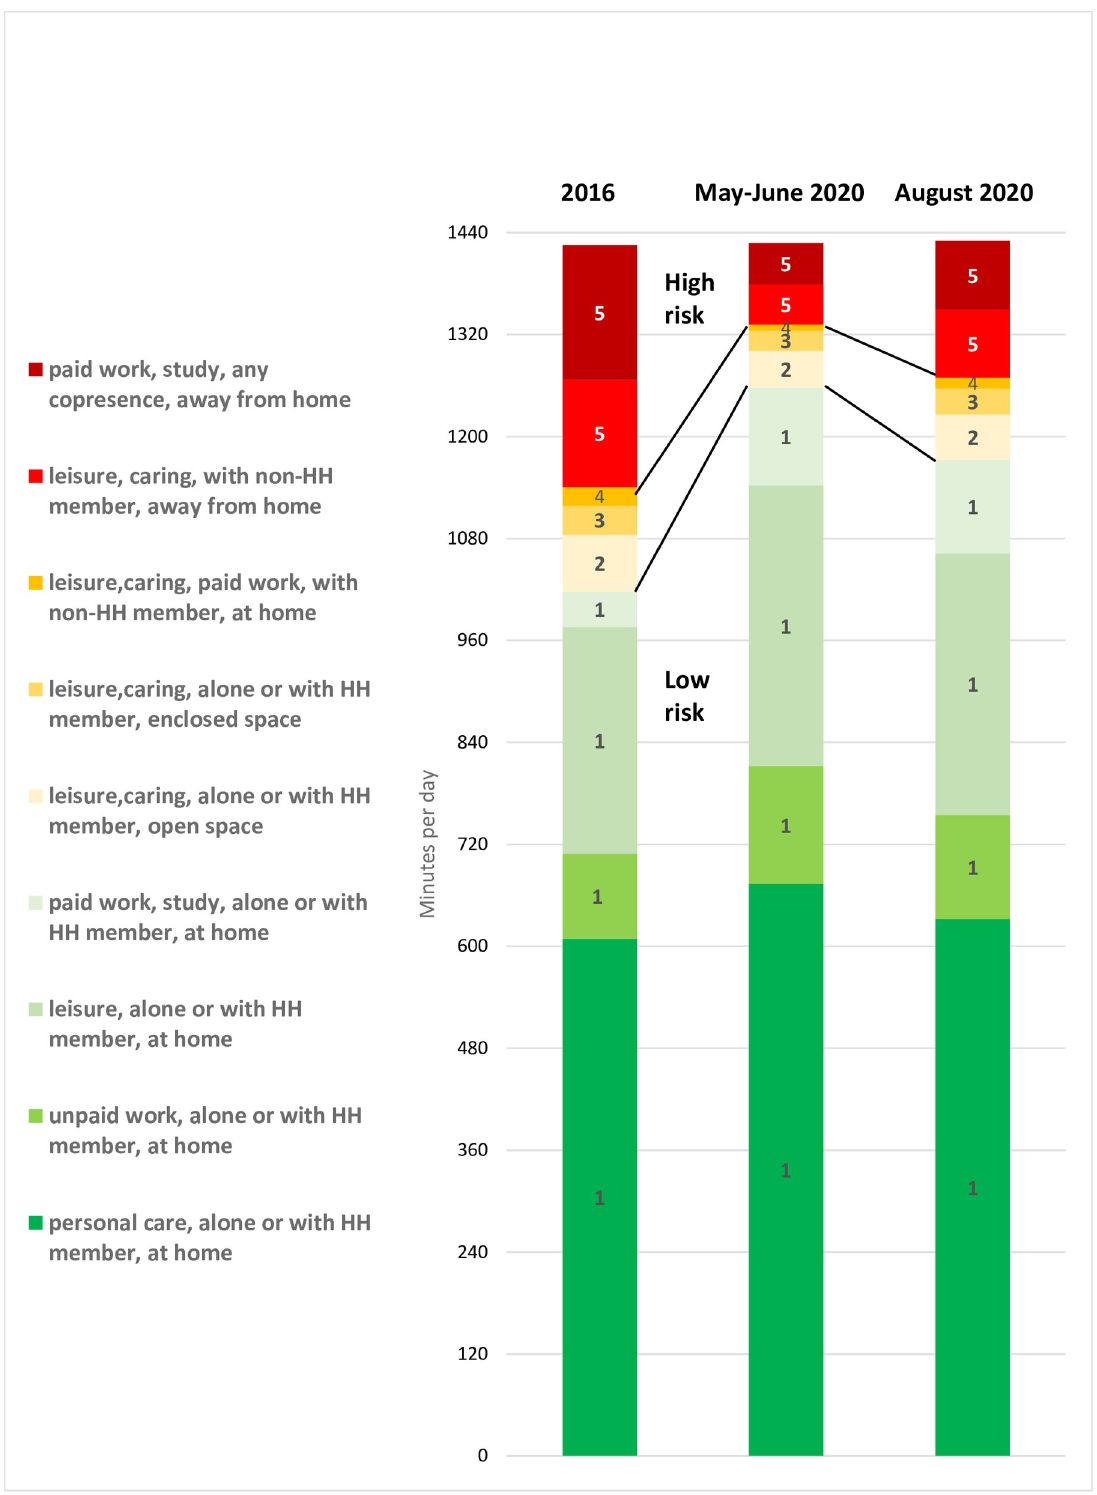
Fig 1. Mean minutes per day spent at 5 different behavioral risk levels, grouped by activity/copresence/location combinations: UK population pre- first lockdown, mid- first lockdown and following lockdown.